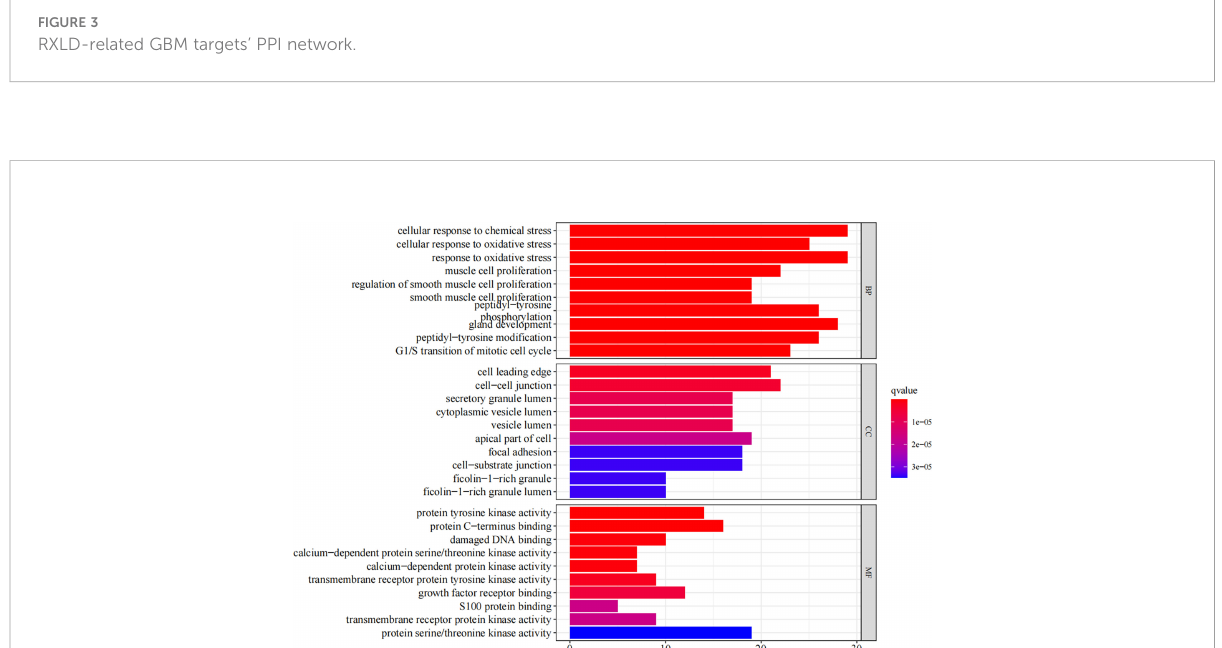
FIGURE 4 The GO enrichment analysis (BP, CC, MF) of the RXLD-related GBM targets (top